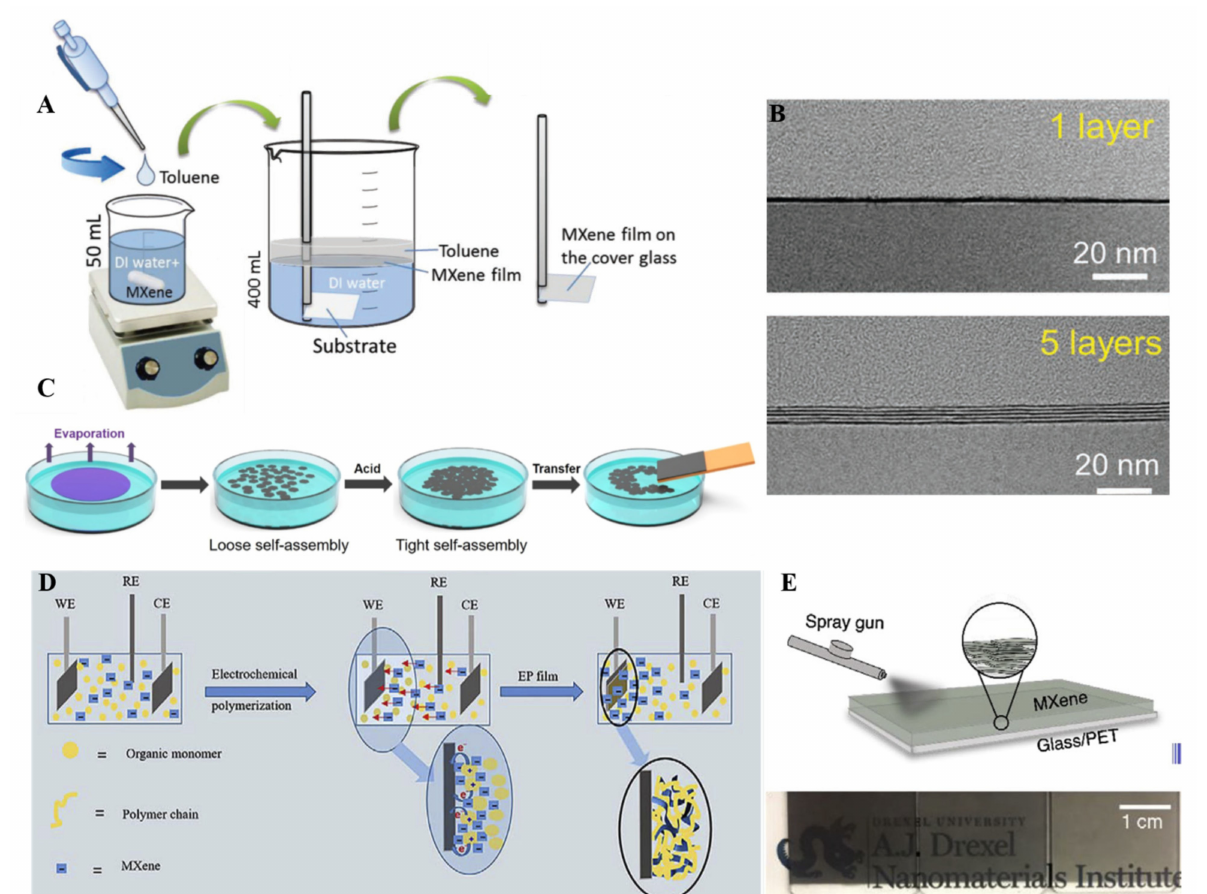
Figure 8. ( A ) Interfacial self-assembly method used for the fabrication of Ti 3 C 2 MXene thin film with varied thicknesses (reproduced with permission [101]. Copyright 2018, Wiley-VCH); ( B ) Cross- sectional TEM images of the monolayer by monolayer, one layer, and five layers Ti 3 C 2 MXene thin films fabricated by interfacial self-assembly technique (reproduced with permission [103]. Copy- right 2019, American Chemical Society); ( C ) The interfacial assembly used for tightness of Ti 3 C 2 MXene films (reproduced with permission [104]. Copyright 2020, Wiley-VCH); ( D ) Electrochemical polymerization process used to fabricate Ti 3 C 2 MXene films (reproduced with permission [105]. Copyright 2019, Elsevier); ( E ) Spray gun-based method for the Ti 3 C 2 film fabrication (reproduced with permission [106]. Copyright 2019,